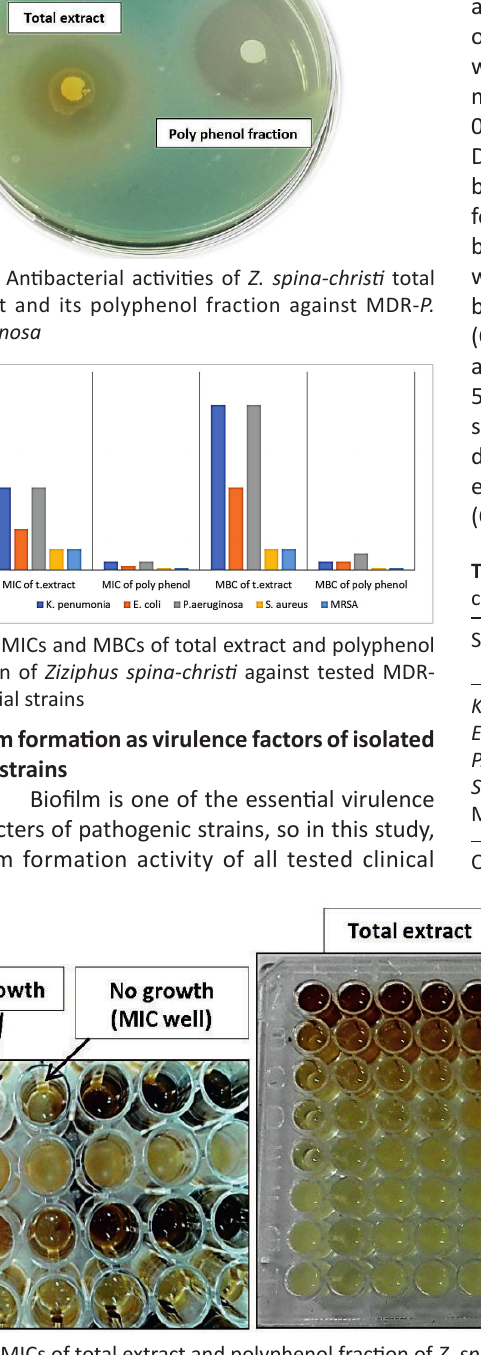
Fig. 6. MICs of total extract and polyphenol fraction of Z. spina-christi against tested MDR-bacterial isolates using the microdilution method